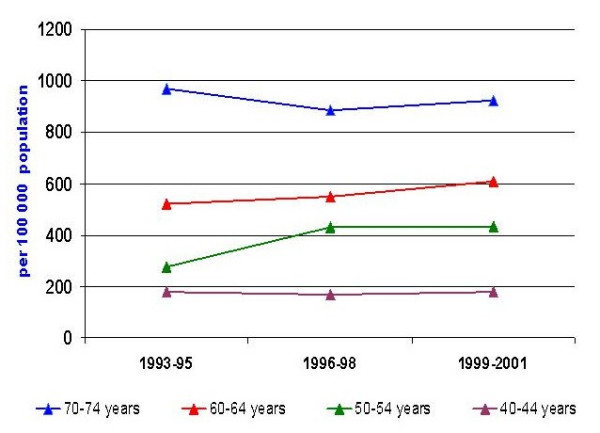
Trend in age-group specific cancer incidence among women in Arkhangelskaja Oblast, all sites combined.